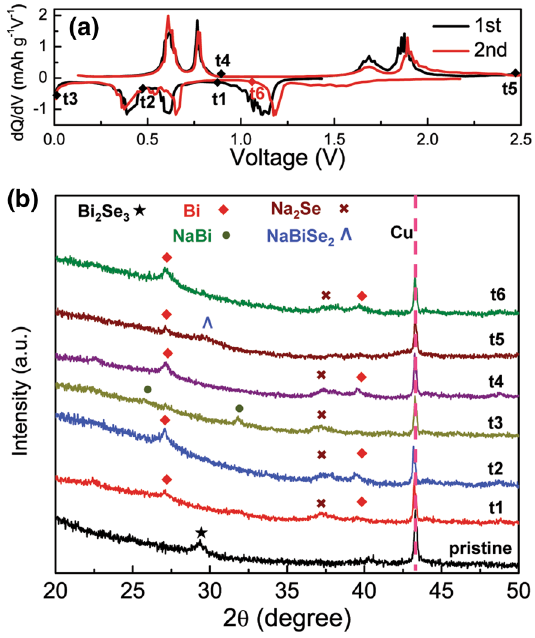
Fig. 3 ad Q /d V plots for the first two cycles and b ex-situ XRD results of the Bi 2 Se 3 /C